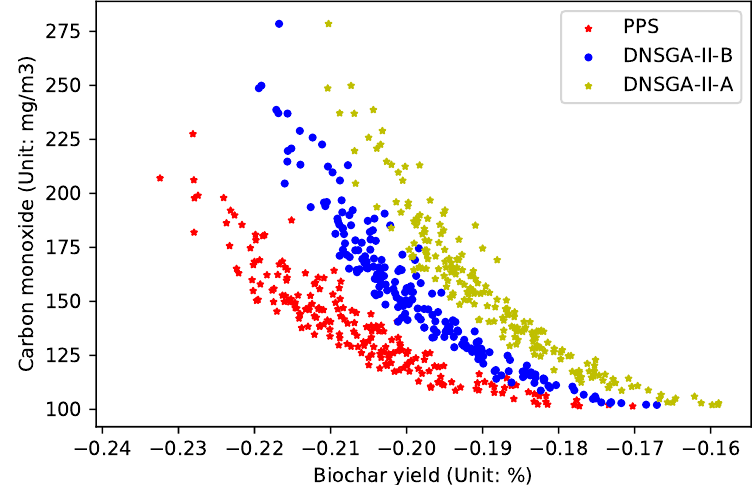
Figure 4. Obtained POF of three algorithms with τ t = 50.